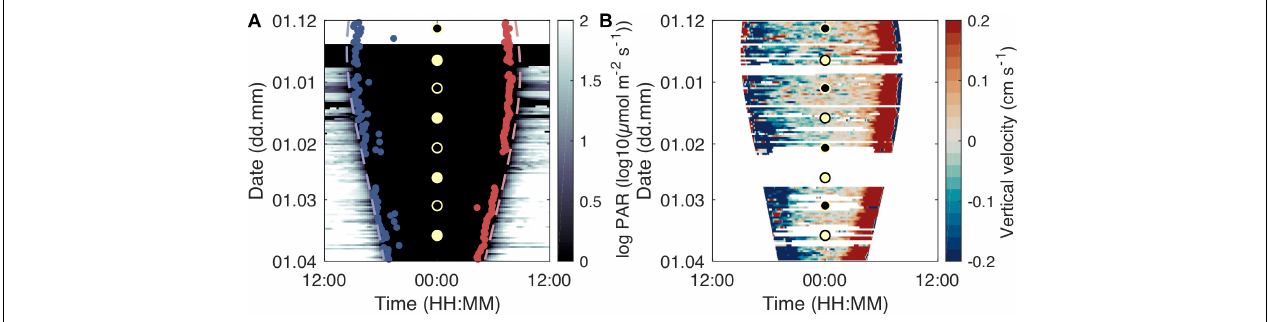
FIGURE 4 | Development of migration timing and velocity over daytime and season. Light intensity and start of dusk descent (beginning of midnight sinking; blue dots) and end of morning ascent (end of midnight sinking; red dots) over the study period and daytime (A) . The dashed lines indicate sunset (blue) and sunrise (red). Development of scattering layer vertical velocity over daytime and the study period (B) . Warm colors denote upward movement of the scattering layer while cold colors show a downward movement. The circles indicate full moon (yellow fill) and new moon (black